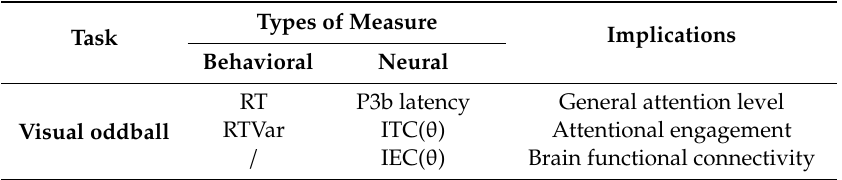
Table 2. Summary of outcome measures. RT—response time; ITC—inter-trial coherence; IEC—inter- electrode coherence.